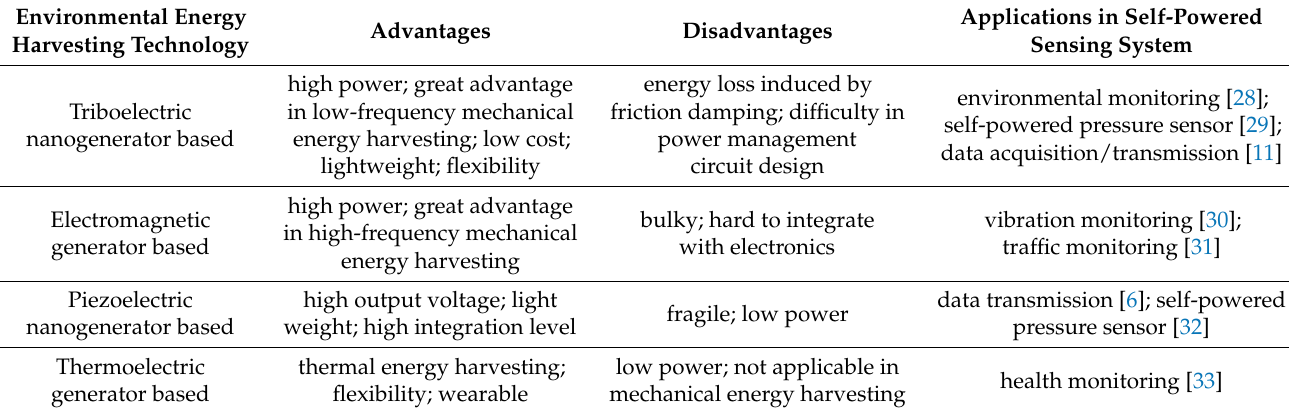
Table A1. The comparison of different environmental energy harvesting technologies in self-powered sensing system applications. Environmental